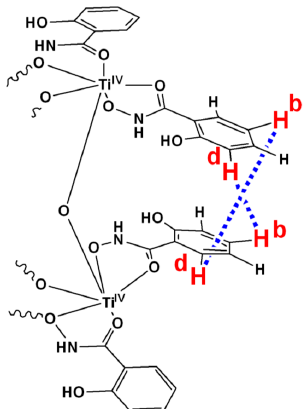
In addition, the 2D { 1 H} NOESY-EXSY spectrum showed two NOESY cross-peaks between protons H( b ) and H( d ) (See Figure 6) having the same phase with the diagonal peaks (Figure 7, blue circles). Despite the opposite phase than the expected one, Figure 7. Two-dimensional { 1 H} grNOESY of 1 . The blue lines show the chemical exchange between the titanium complexes and the free ligand. The red lines show the chemical exchange between the titanium complexes. In the blue circles, NOESY peaks between H( d ) and H( b ) protons of two chelating Hdihybe − ligands (Scheme 2). H( a )–H( d ) the protons of the ligand shown in Figure 6. * The H(d)- 1 H NMR peaks of the minor titanium complex 2 (See Supplementary Material; Table S1).